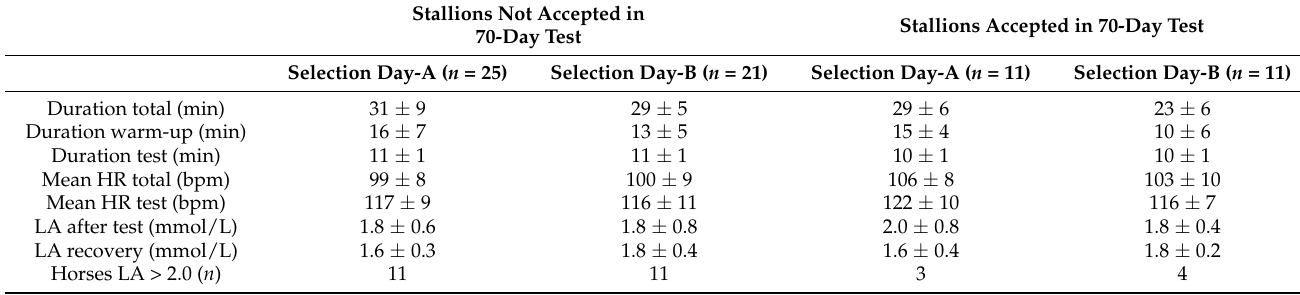
Table 2. Mean ± SD duration (min), plasma lactate concentration (LA, mmol/L) and heart rate (HR, bpm) at selection day-A and selection day-B in the preparation period before the 70-day test in young Friesian